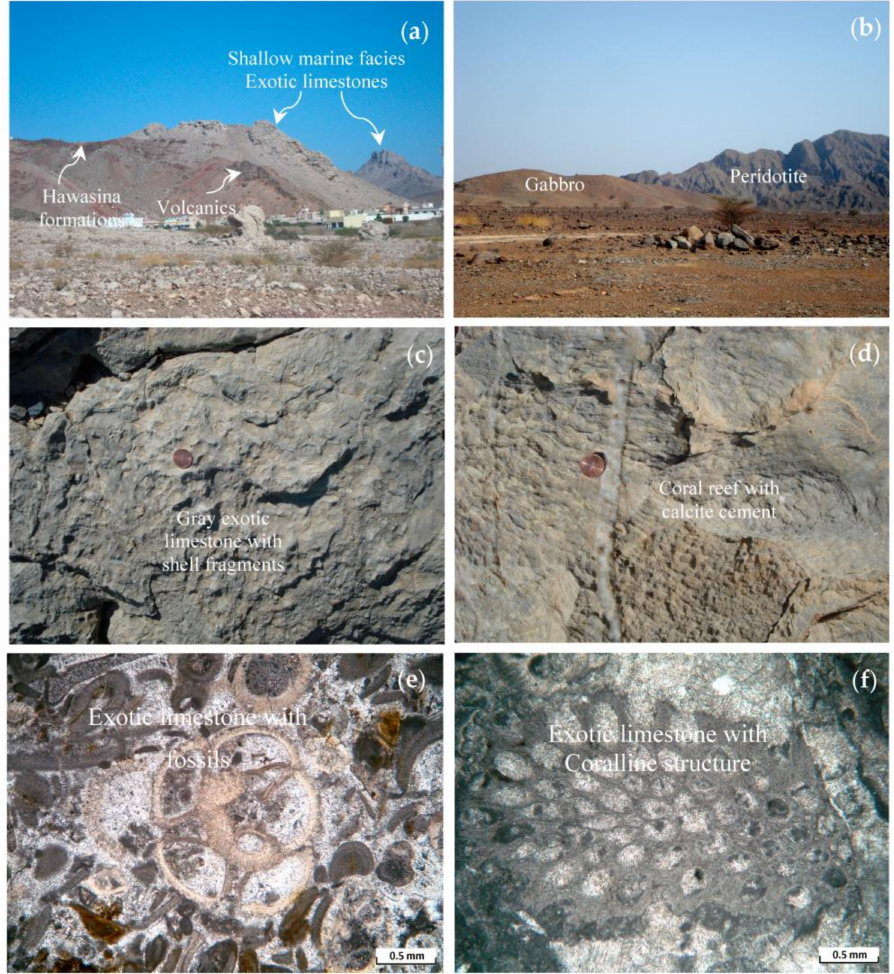
Figure 5. Field photographs. ( a ) Exotic limestones of shallow marine facies; ( b ) Peridotite and Gabbro; ( c ) Massive grey exotic limestone; ( d ) Fossil shell fragments; Photomicrographs (crossed polarized) of ( e ) Fossils; ( f ) Corallines in the exotic limestones of shallow marine